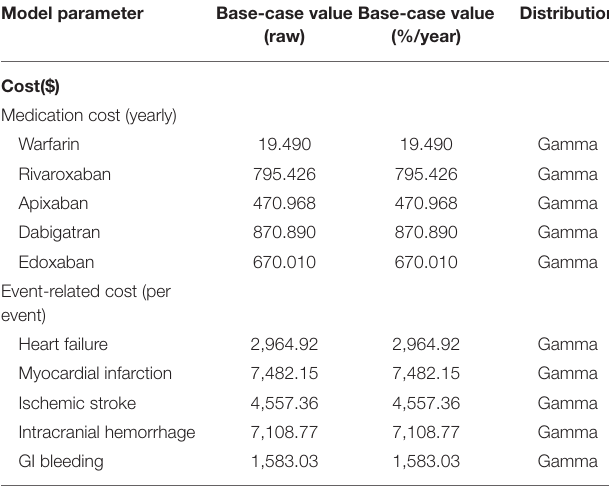
TABLE 4 | Cost used in base-case analysis.